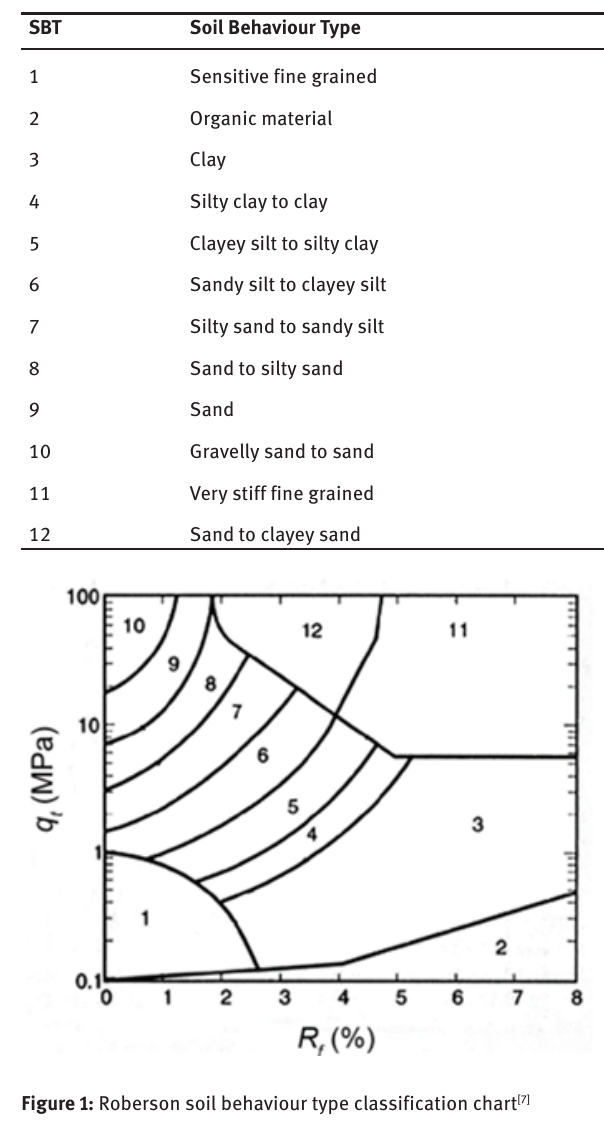
Figure 1: Roberson soil behaviour type classification chart